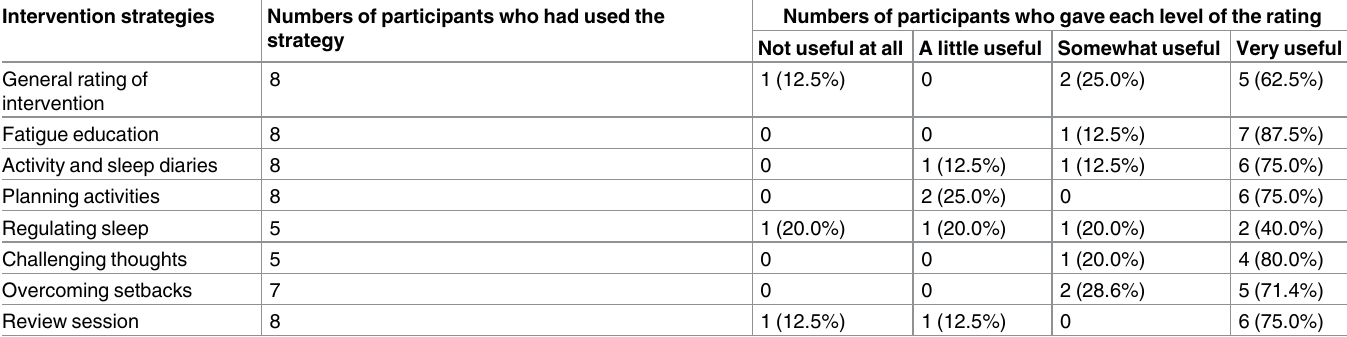
Table 3. Participant ratings of the usefulness of the intervention (n = 8).